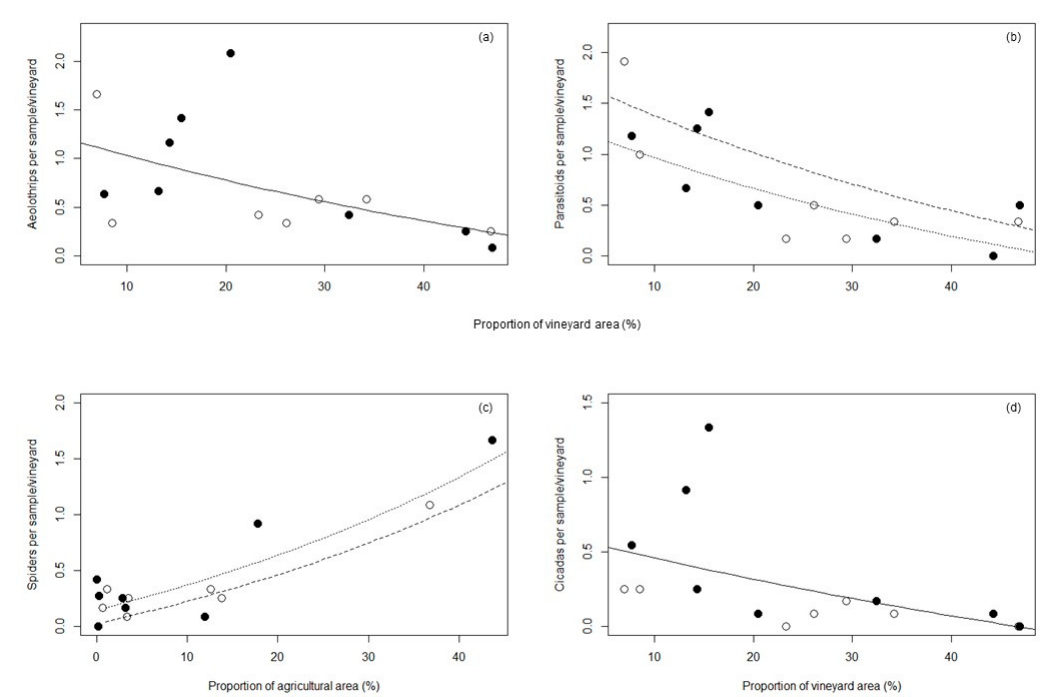
Figure 3. Model predictions and influence of landscape factors on the mean abundance of beneficial arthropods: ( a ) aeolothrips; ( b ) parasitoids; ( c ) spiders; and herbivorous insects: ( d ) cicadas. Dashed lines/black symbols represent the abundance of arthropods in vineyards with vegetation cover, dotted lines/white symbols in vineyards with bare soil. For aeolothrips and cicadas, no differences between vegetation cover and bare soil could be detected (black solid line).